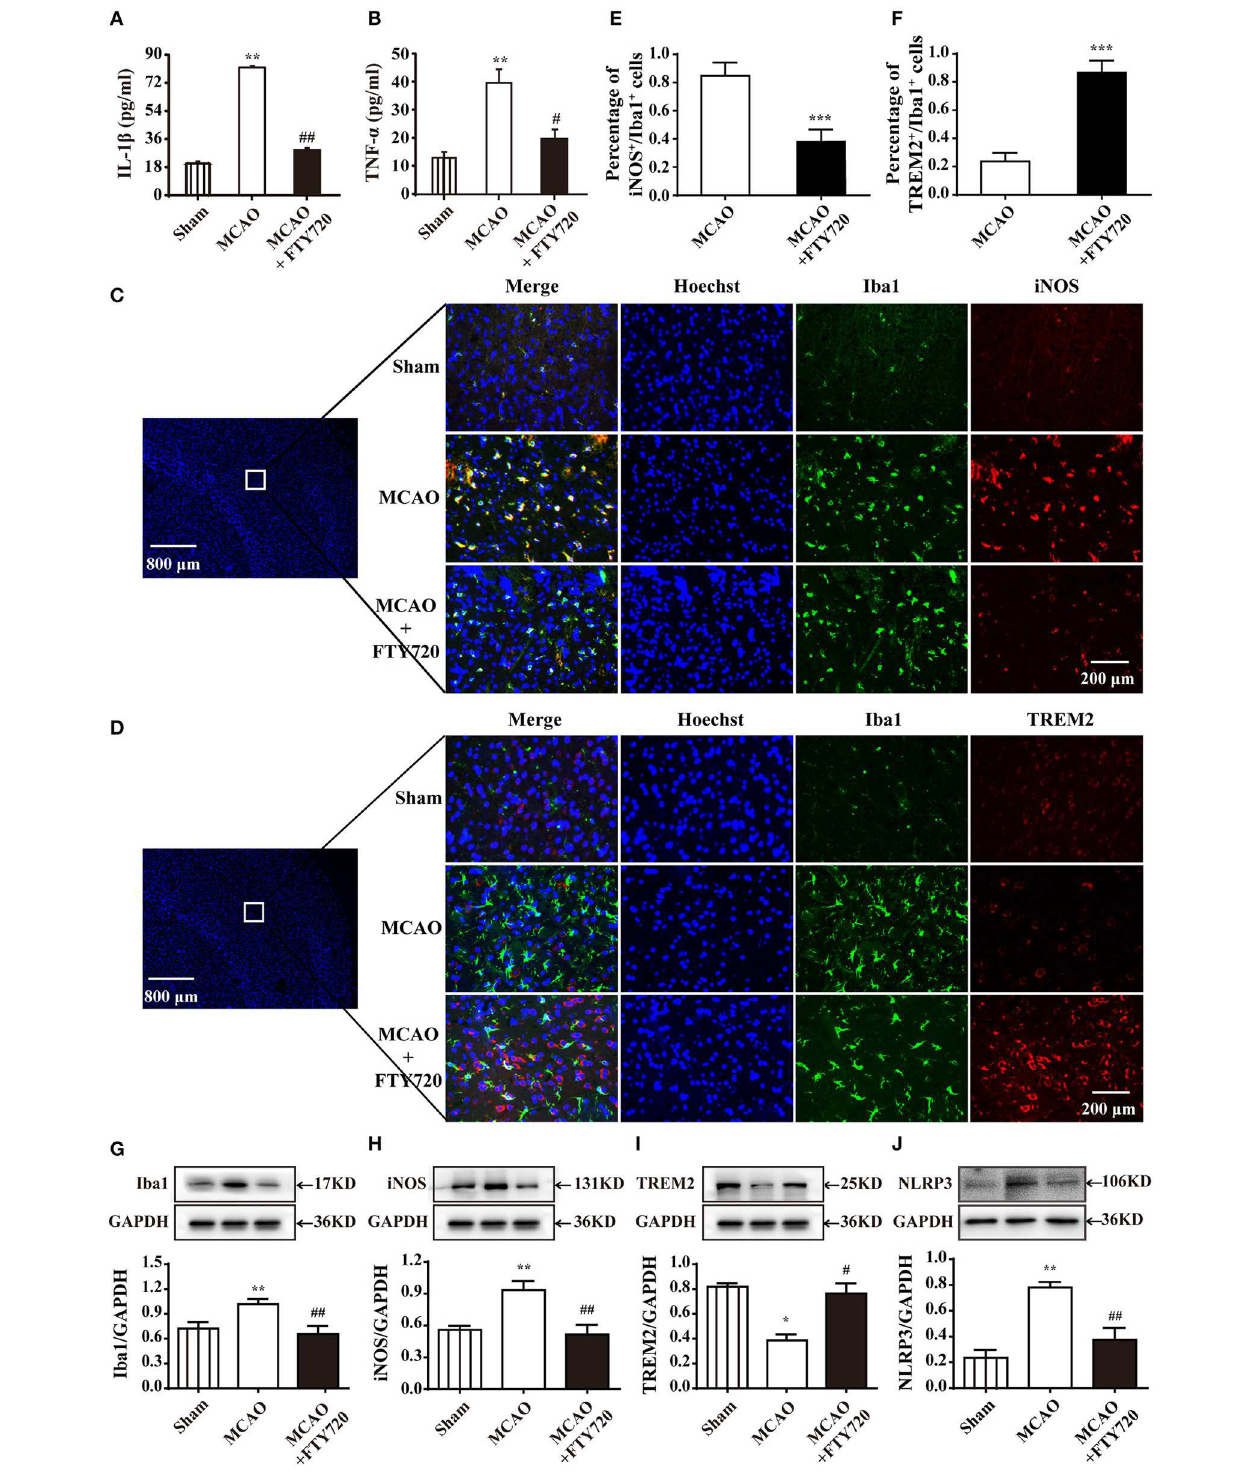
FIGURE 2 | FTY720 treatment reduces the levels of pro-inflammatory factor in the serum and promotes M2 microglial polarization. FTY720 prevented MCAO-induced increases of L-1 β and TNF- α in serum levels (A,B) . n ≥ 8 per group,** p < 0.01, compared to the sham group; # p < 0.05, ## p < 0.01, compared to the MCAO group, by one-way ANOVA and Tukey’s test. (C) Immunofluorescent staining with of Iba1 (green), iNOS (red), and nuclei (blue) in the sham, MCAO, and